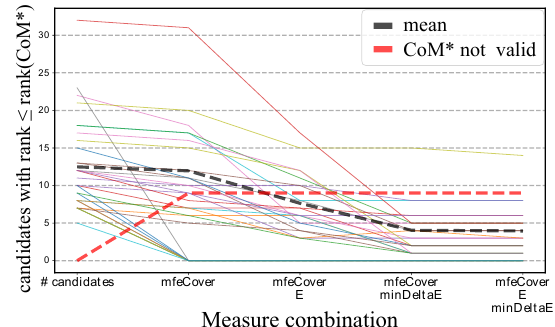
Figure 6. Effect of different classification and sorting combinations on CoM candidate set sizes. Each solid line represents the number of valid CoM candidates for an RNA pair with a rank not higher than the known CoM from literature (designated as CoM*; colors differentiate between the single CoMs). The left-most data points represent the overall numbers of CoM candidates. The black dotted line provides the average over all RNA pairs. The red dotted line depicts the number of RNA pairs for which the known CoM* does not fulfill the